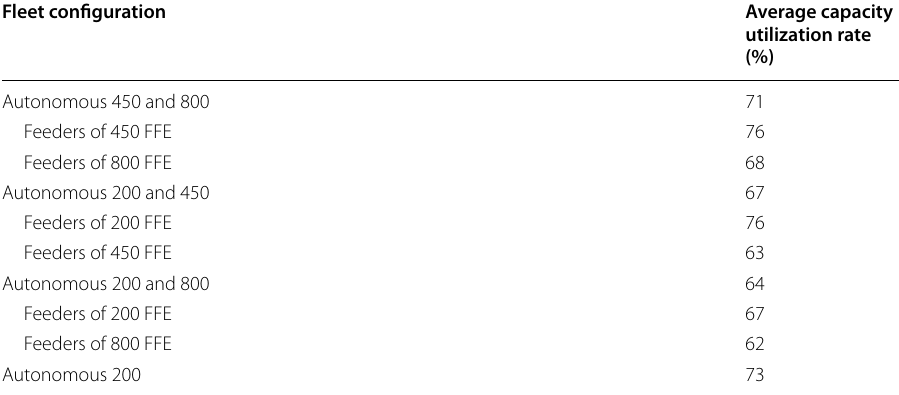
Table 5 Results of LSNDP for capacity utilization under the fixed schedule Fleet